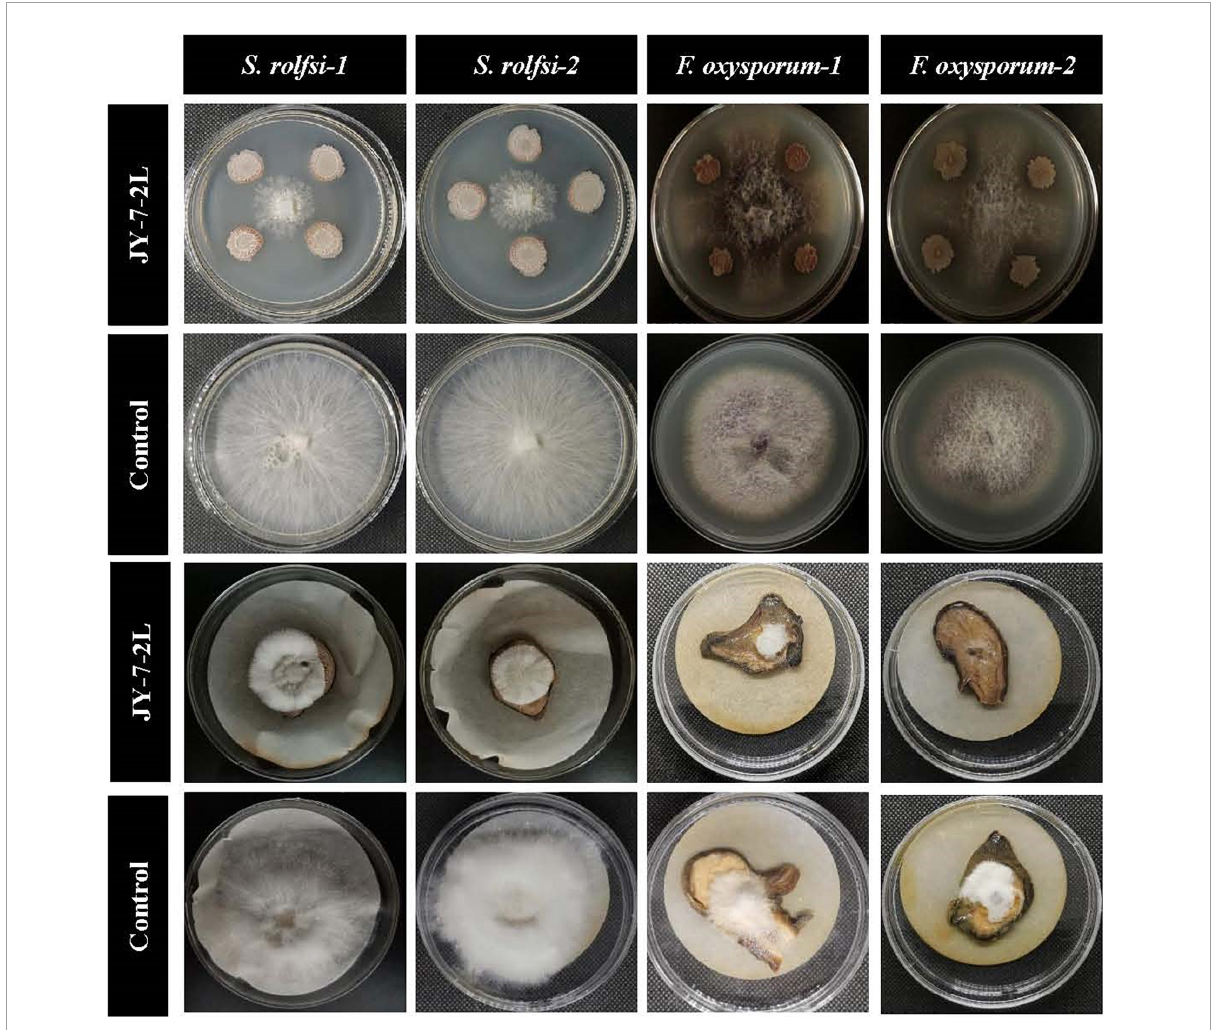
FIGURE2 Antagonistic activity of JY-7-2L against Sclerotium rolfsii and Fusarium oxysporum in vitro and on Aconitum carmichaelii root slices by dual culture method.